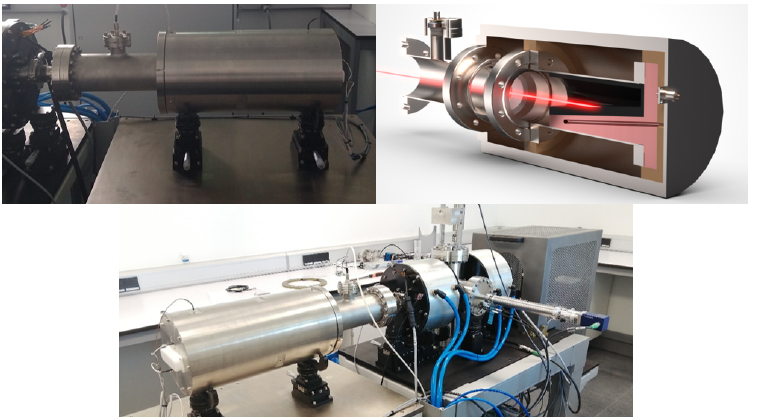
Figure 7. LINAC 7 beam stop (Faraday cup). Installed beam stop at the end of the LEBT for initial testing under low energy. Top right shows a cross-section of the cad model; the slanted impact face is visible